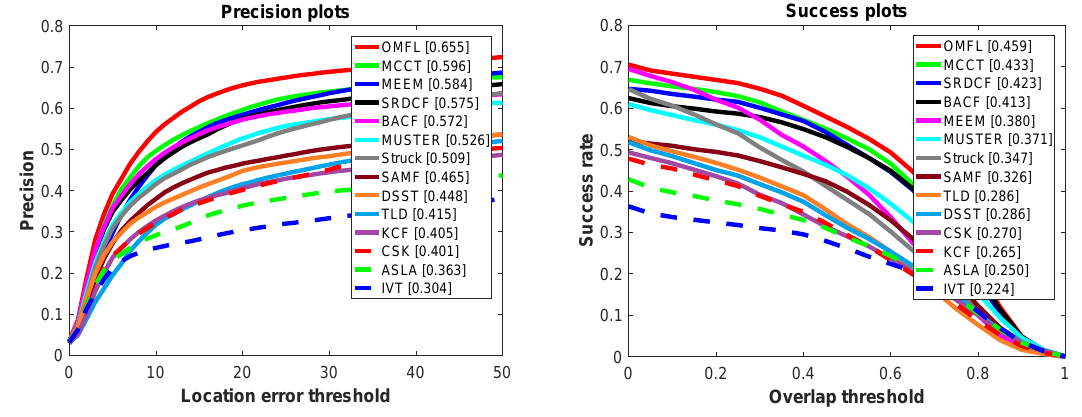
Figure 10. PPs and SPs of all trackers on 123 challenging UAV image